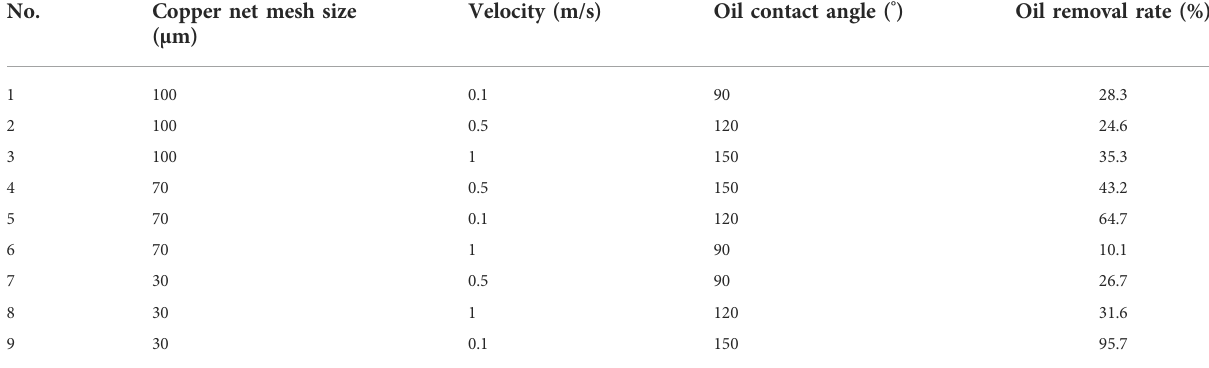
TABLE 3 Orthogonal experiment and results.